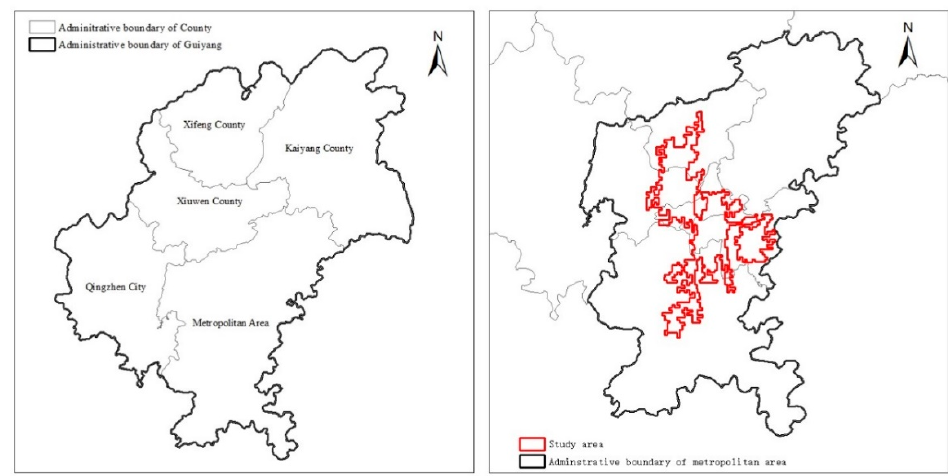
Figure 1. Study area.